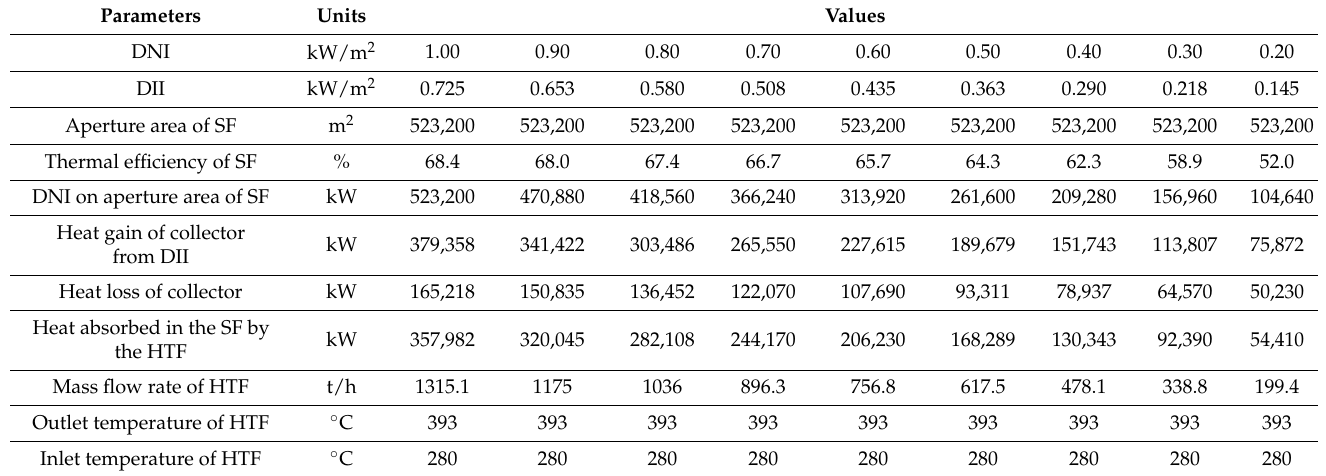
Table 6. The operating performance of the solar field in the part-load